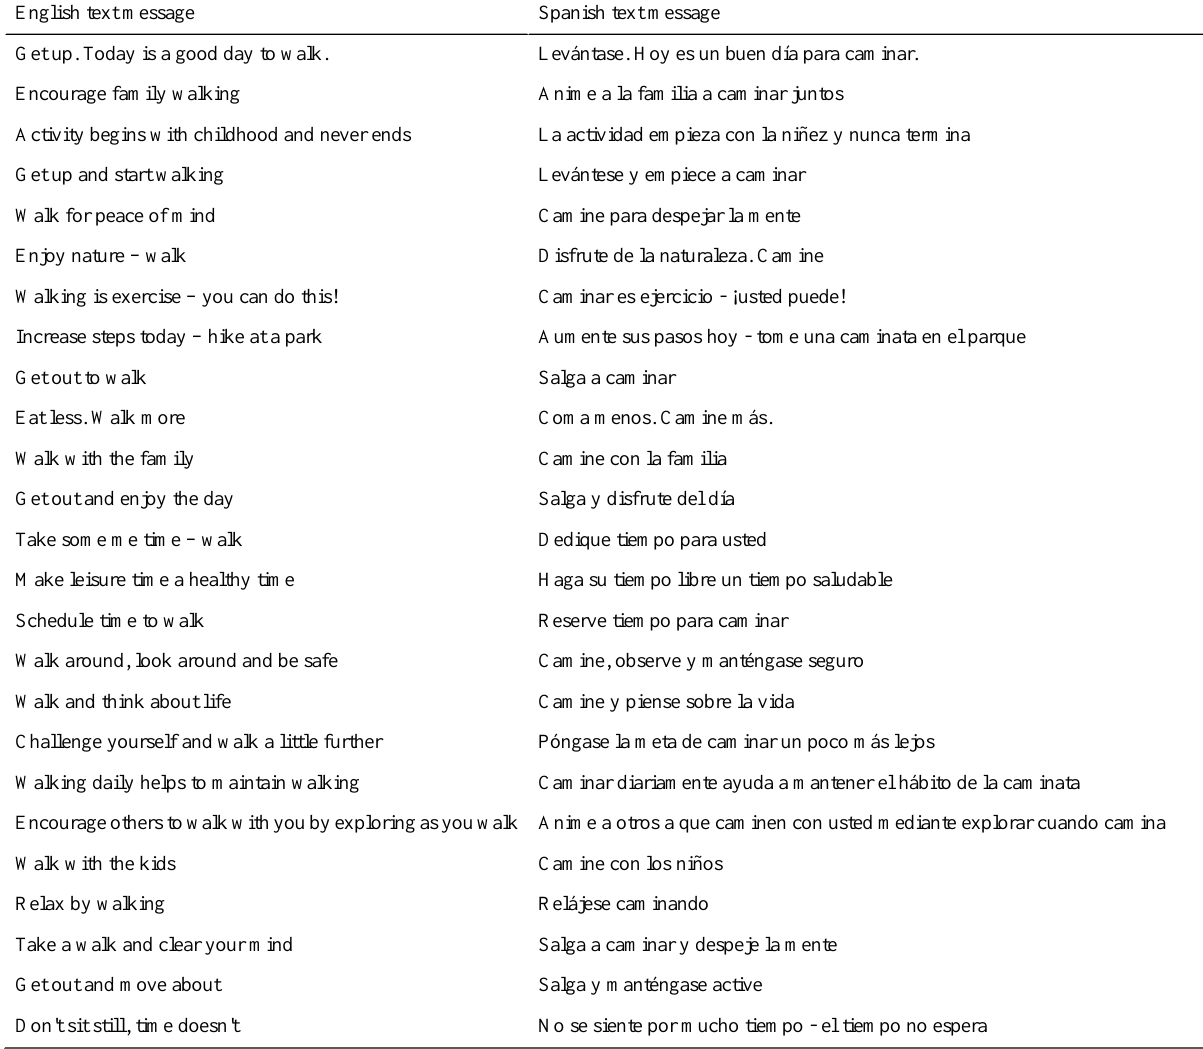
Table 2. Examples of Spanish text messages translated from English.